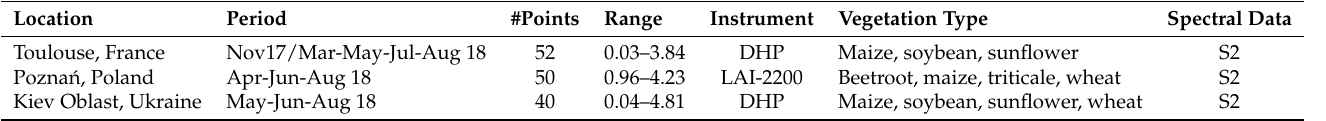
Figure 1. Comparison of the RMSE evolution performance of all active learning (AL) methods ( a ), and scatterplot with goodness-of-fit statistics of validation LAI G data against estimations using the best Euclidean Diversity (EBD)-reduced LAI G GPR model ( b ). Table 2. Overview of campaigns for LAI G in-situ data collection used for LAI G GPR model